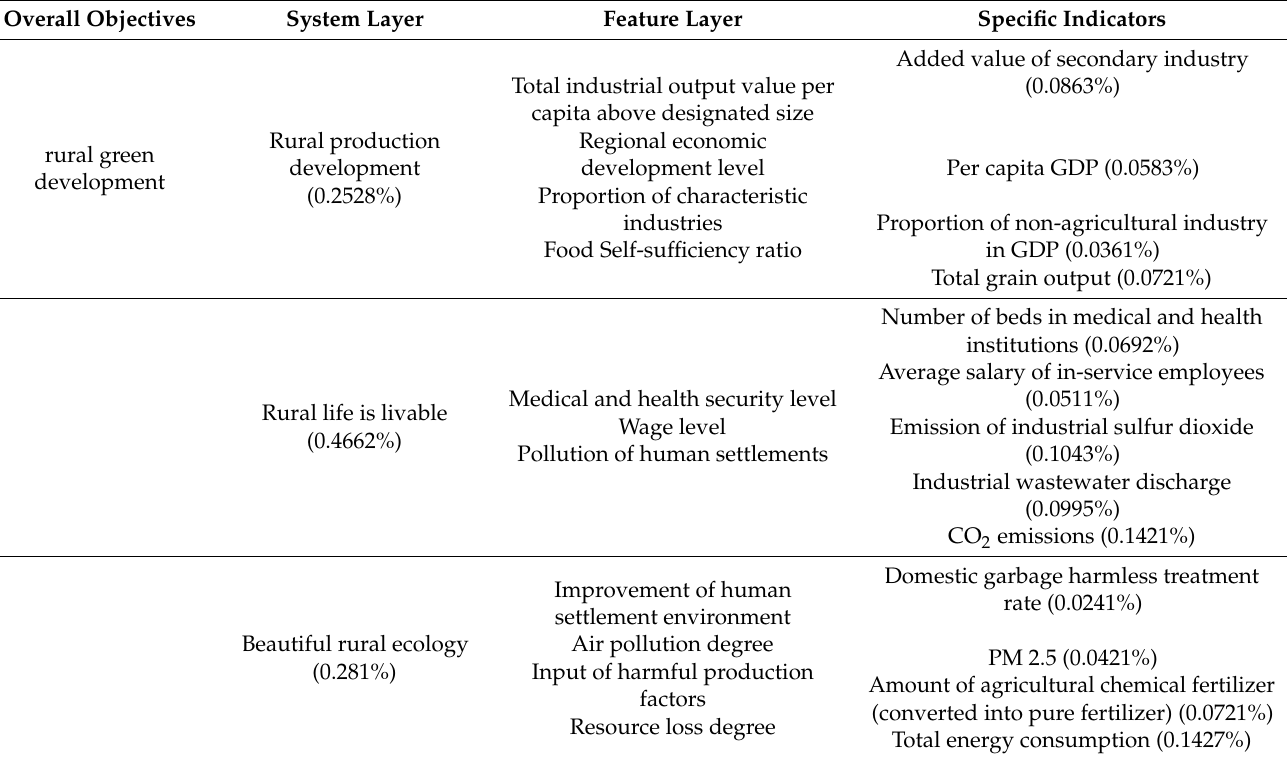
Table 1. Comprehensive indicator evaluation system for rural green development.